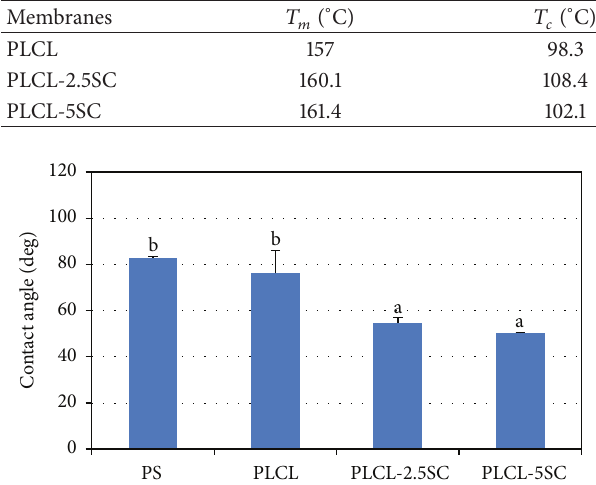
Figure 4: Water contact angle of the membrane surfaces. Statistical difference is indicated by lowercase letters (a, b) ( 𝑝 ≤ 0.05 ).